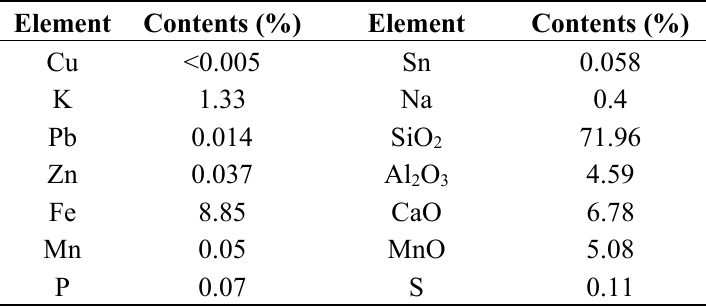
Figure 1. The particle size distribution of Xin-Cheng mill tailings. Table 2. Main chemical elements of mill tailings.